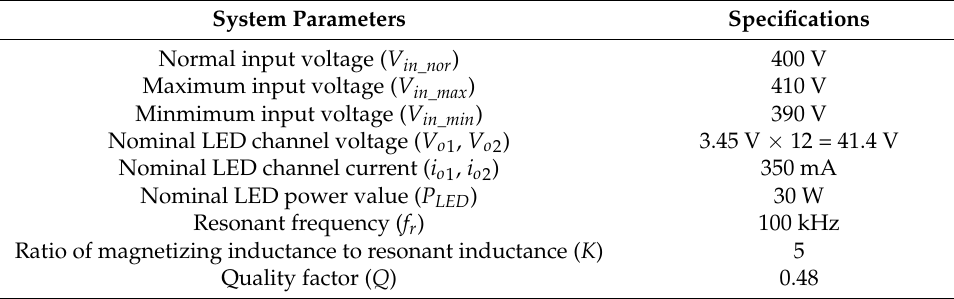
Table 1. System specifications of the proposed LED driver.